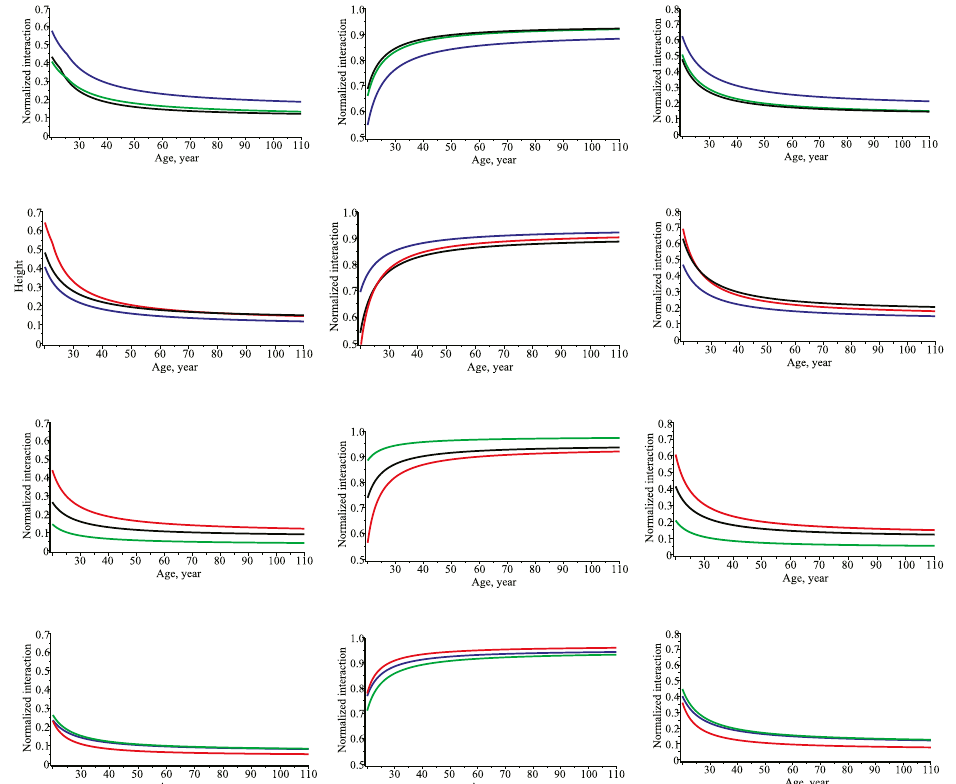
Figure 5. Evolution of trivariate normalized interaction information (Equations (54)–(56)). Left column—Equation (54). Middle column—Equation (55). Right column—Equation (56). First row for diameter as a response variable and predictors: black—height and crown base height; blue—crown base height and crown width; green—crown base height and crown width. Second row for height as a response variable and predictors: black—diameter and crown base height; blue—diameter and crown width; red—crown base height and crown width. Third row for crown base height as a response variable and predictors: black—diameter and height; green—diameter and crown width; red—height and crown width. Fourth row for crown width as a response variable and predictors: blue—diameter and crown base height; green—diameter and crown base height; red—height and crown base height.